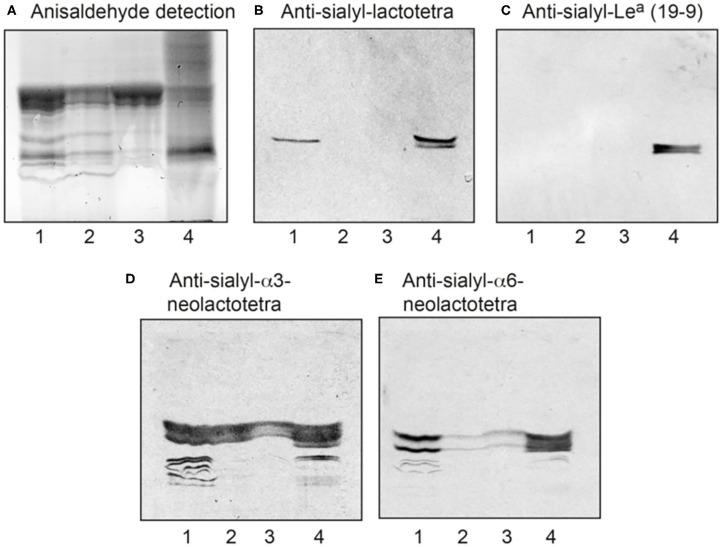
Characterization of the acid glycosphingolipids of ovarian cancers by binding of monoclonal antibodies. (A) Thin-layer chromatogram after detection with anisaldehyde, and autoradiograms obtained by binding of the monoclonal antibodies directed against (B) sialyl-lactotetra, (C) sialyl-Lea, (D) sialyl-α3-neolactotetra, and (E) sialyl-α6-neolactotetra. Lane 1, total acid glycosphingolipids of ovarian cancer (Case 1), 40 μg; Lane 2, total acid glycosphingolipids of ovarian cancer (Case 2), 40 μg; Lane 3, total acid glycosphingolipids of ovarian cancer (Case 3), 40 μg: Lane 4, reference total acid glycosphingolipids of liver cancer lung metastasis, 40 μg.